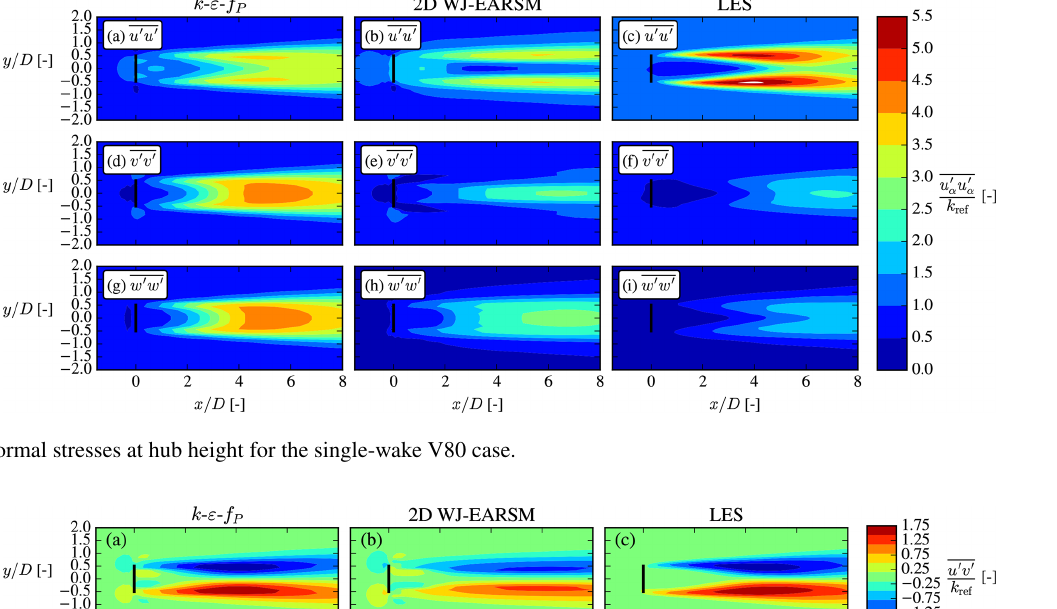
Figure 17. Normal stresses at hub height for the single-wake V80 case.